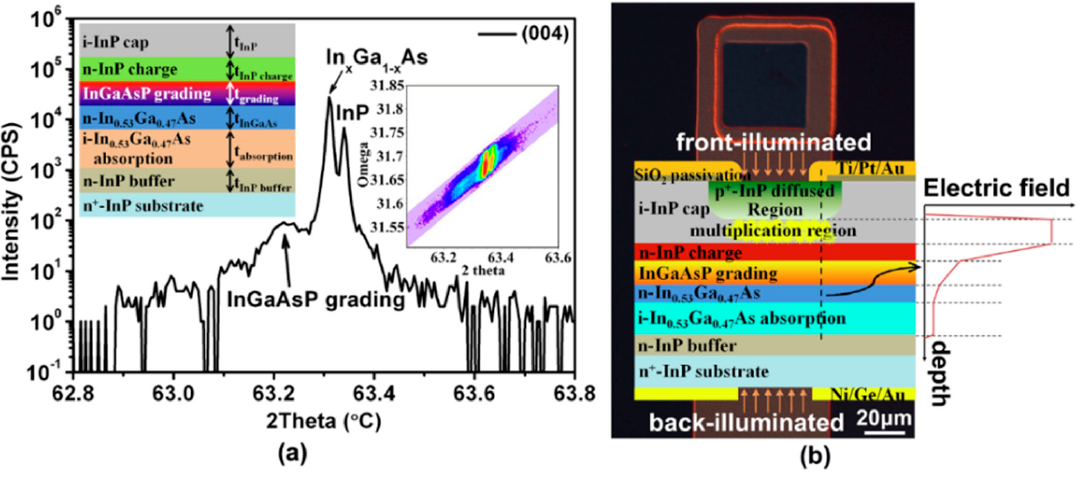
Figure 39. ( a ) HR-XRD scan and device layer structure; ( b ) double side illuminated SAGCM InGaAs/InP APDs with electric field distribution. Reproduced with permission from [93], Elsevier, 2022.